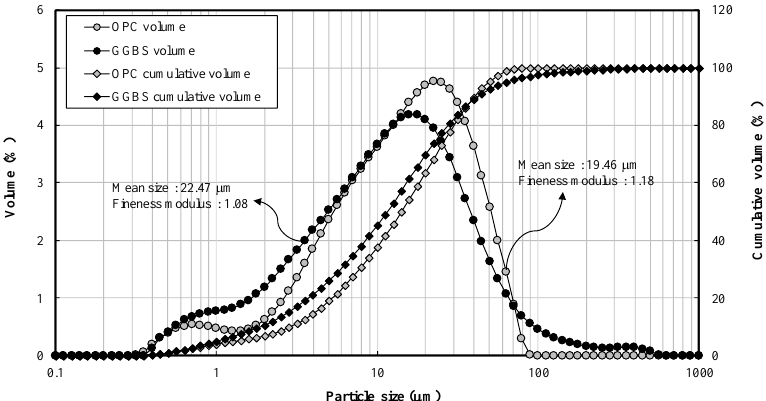
Figure 1. Particle size distribution of ordinary Portland cement (OPC) and ground granulated blast-furnace slag (GGBS).